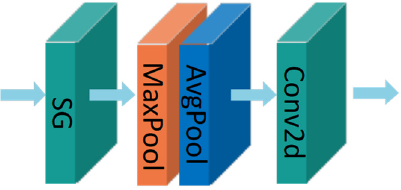
Figure 3. Architecture diagram of the edge-guided extraction module.